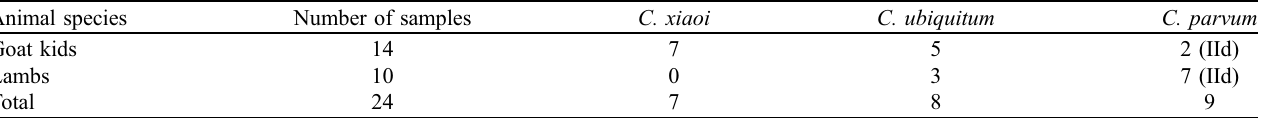
Table 3. Results for molecular identification of Cryptosporidium positive samples in goat kids and lambs. Animal